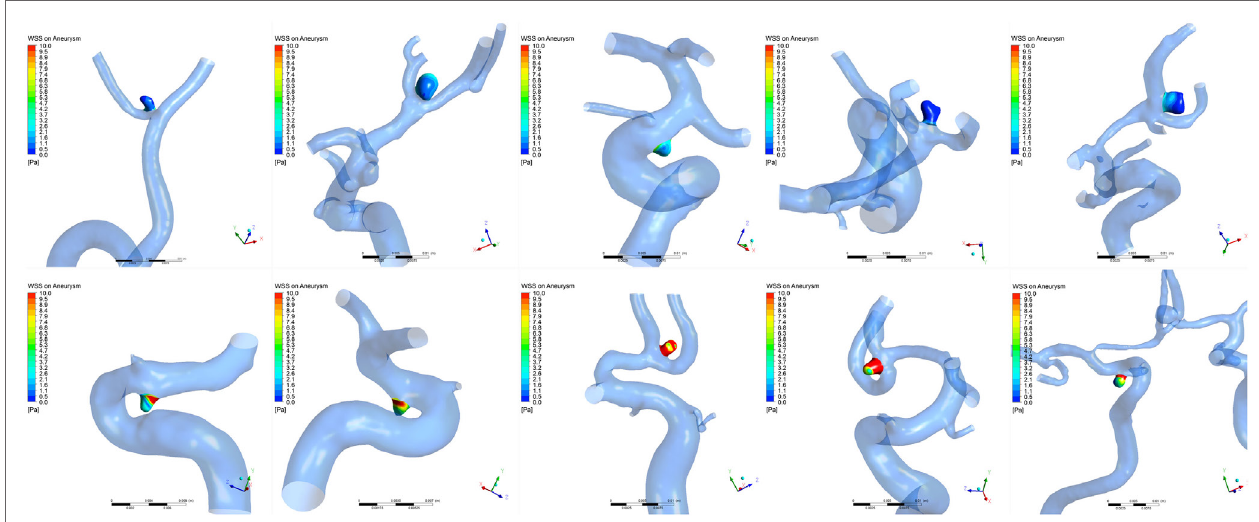
FigUre 2 | Time-averaged wall shear stress distribution on very small intracranial aneurysms . The top row shows a series of ruptured aneurysms and the bottom row shows a series of unruptured aneurysms. Wall shear stress was significantly lower in ruptured very small intracranial aneurysms compared with unruptured